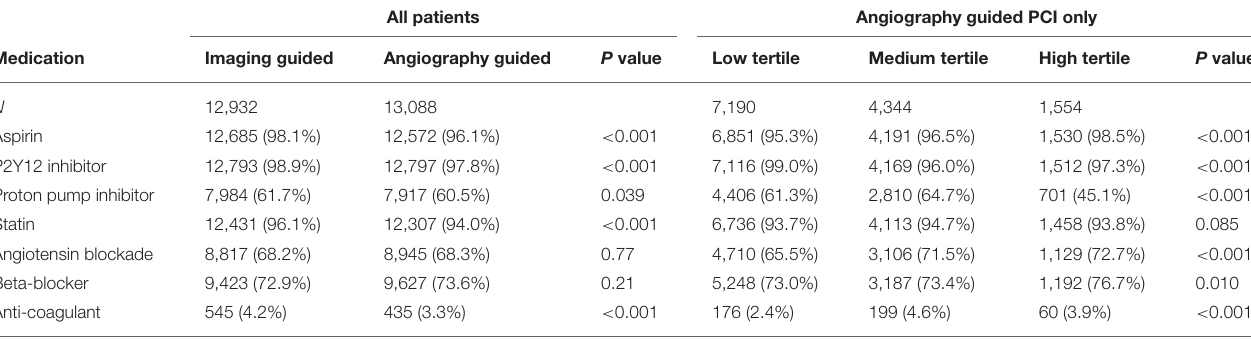
TABLE 3 | Medication prescription on hospital discharge. All patients Angiography guided PCI only